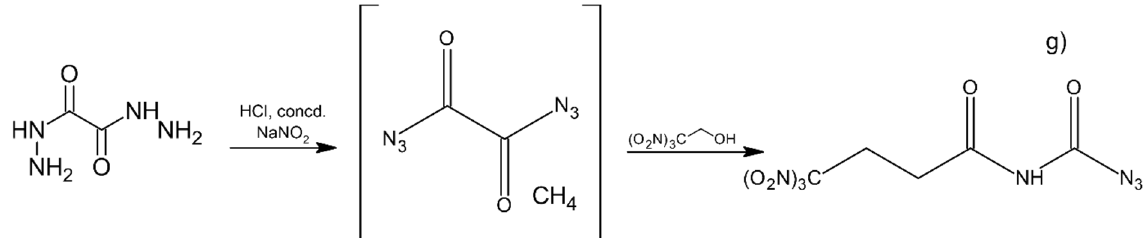
Figure 7. Synthesis of 2,2,2-trinitroethylcarbamate carbonyl azide.